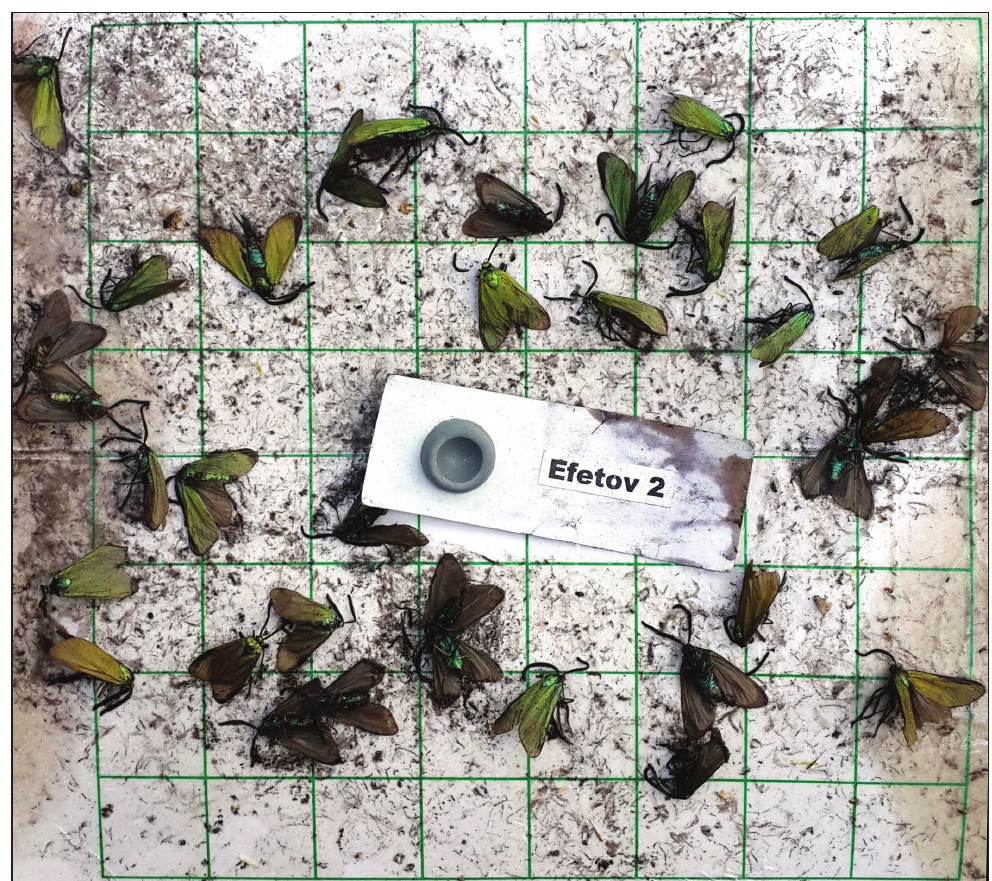
Figure 2. Sticky trap baited with EFETOV-2 with 34 males of Adscita statices drenowskii , Province Tekirdağ, Çorlu Velimeşe,